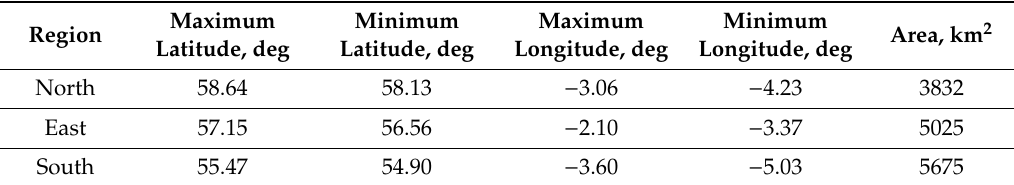
Table 6. Selected regions for coverage simulation.